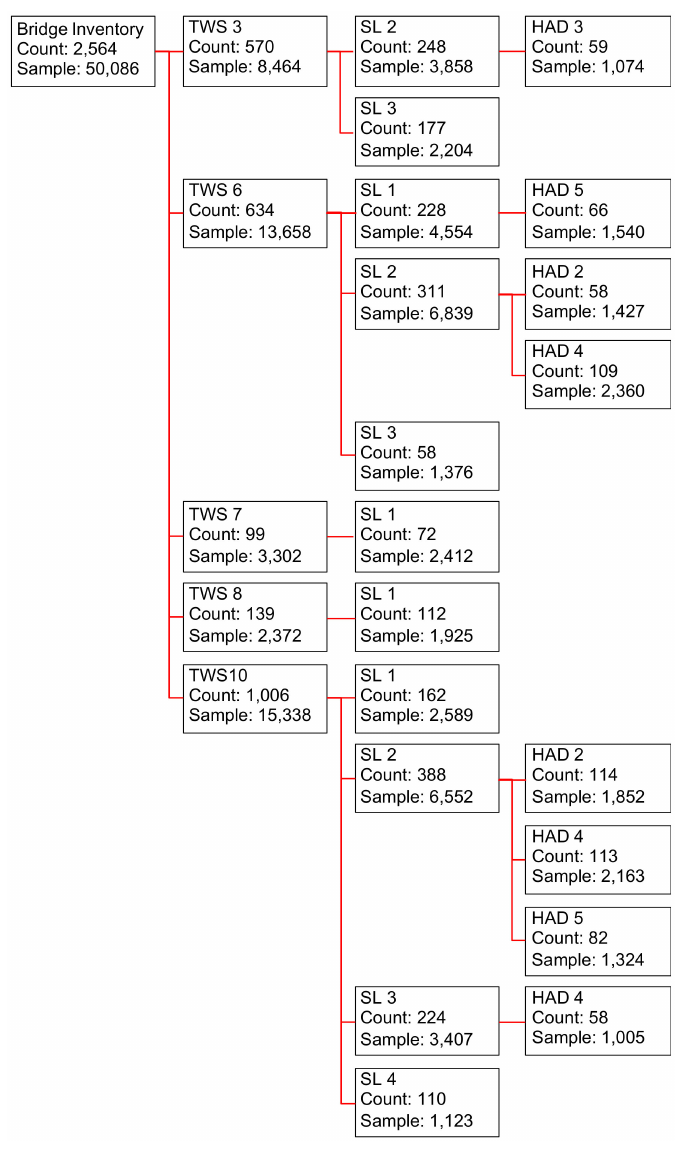
Figure 5. Classification tree for Wyoming bridges using explanatory variables from eight years (2006-2013) of inspection data for deck